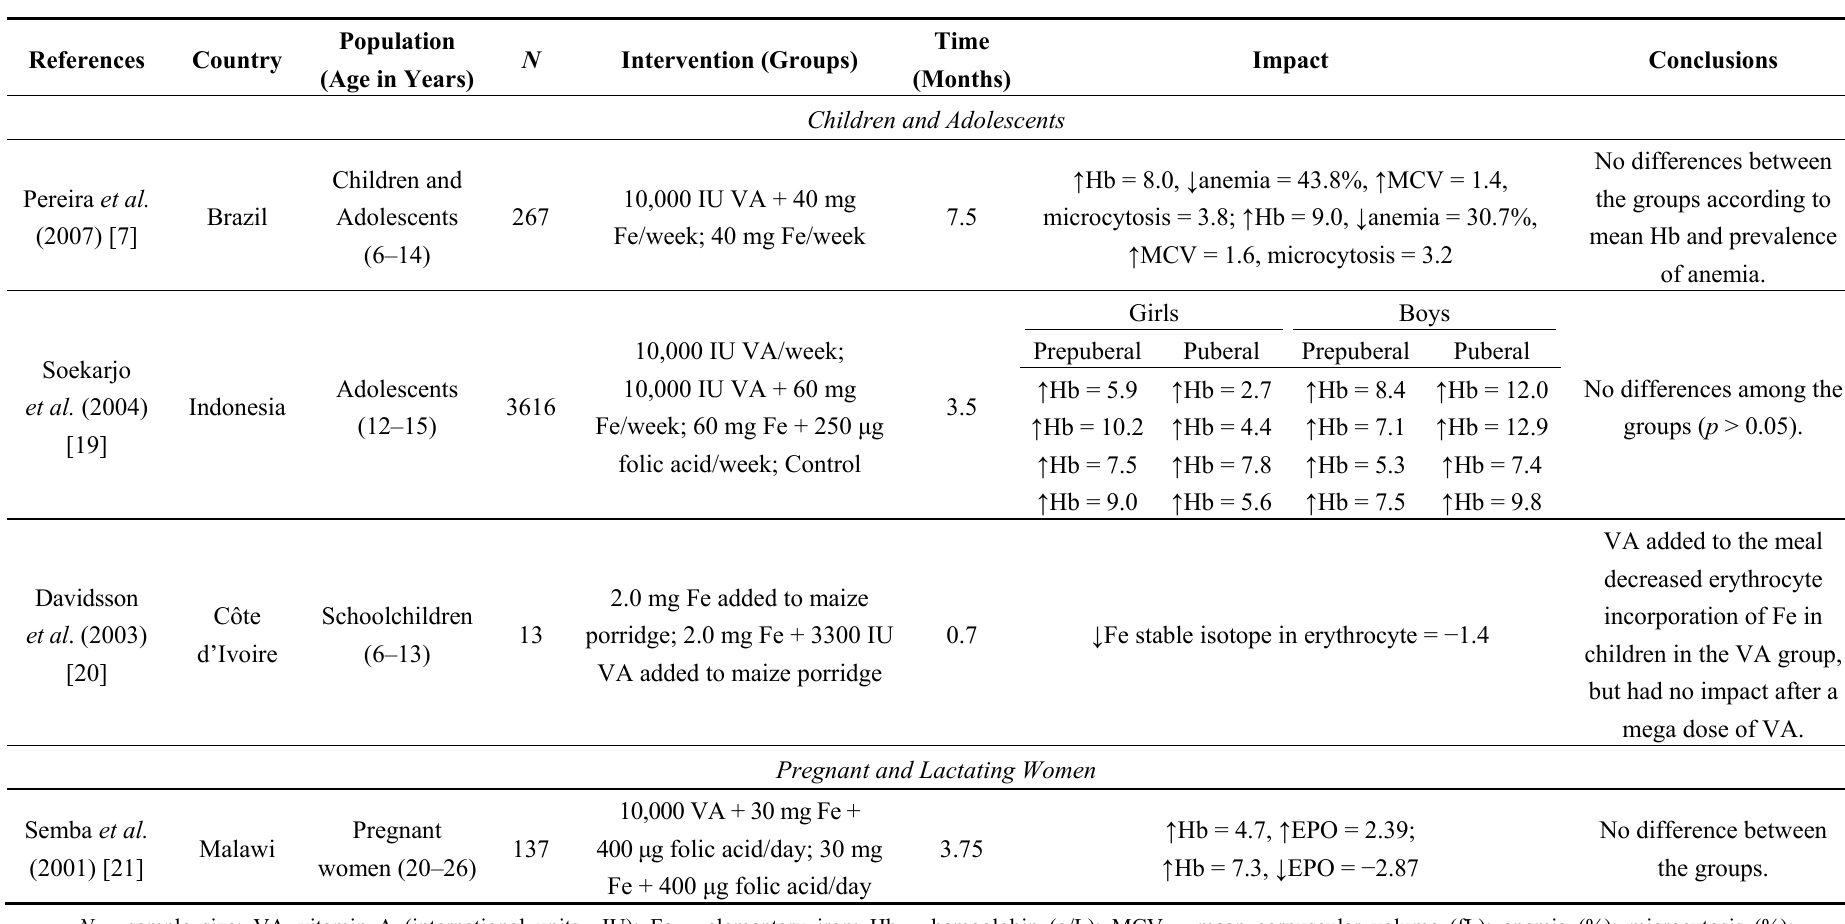
Table 2. Clinical trials that showed no significant impact of vitamin A supplementation/fortification alone or in combination with iron, folic acid and vitamin C on iron